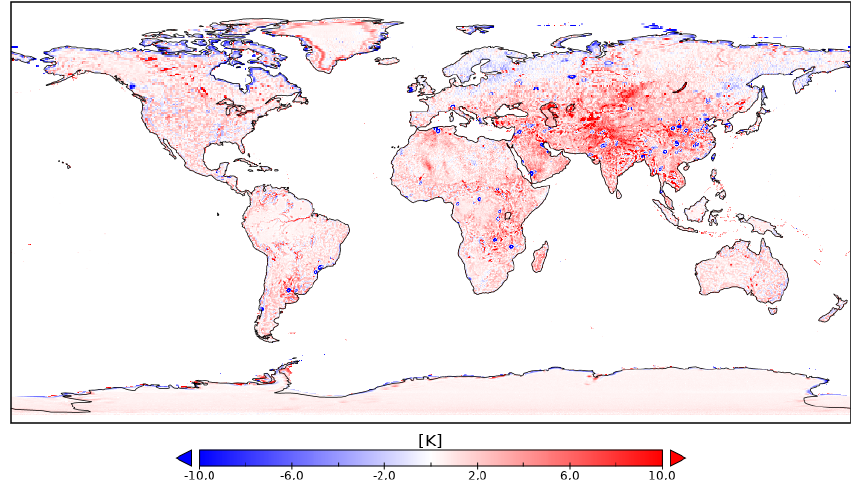
Figure 16. Map of the difference between the error standard deviation of SMOS nominal and SMOS NS TBs (mean reduction of the error standard deviation led by NS: 0.99